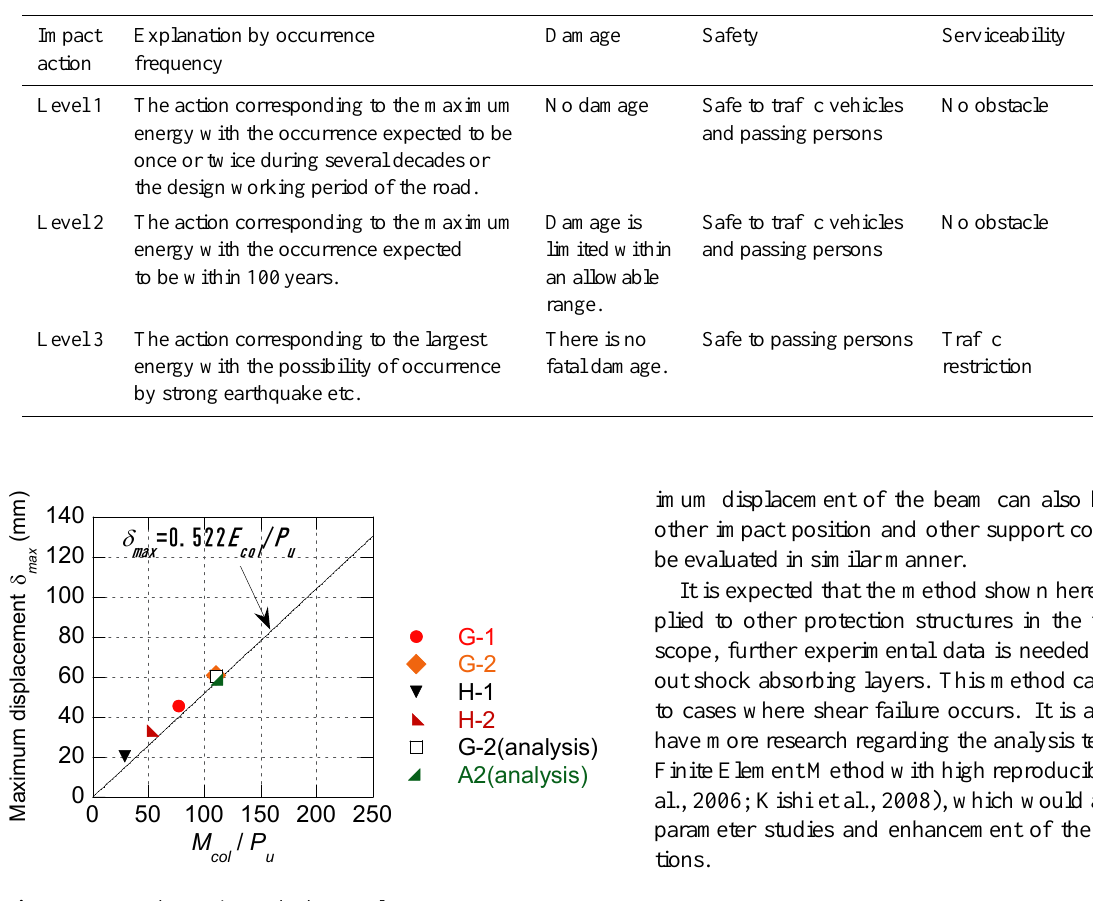
Fig. 17. Proposed equation and other results